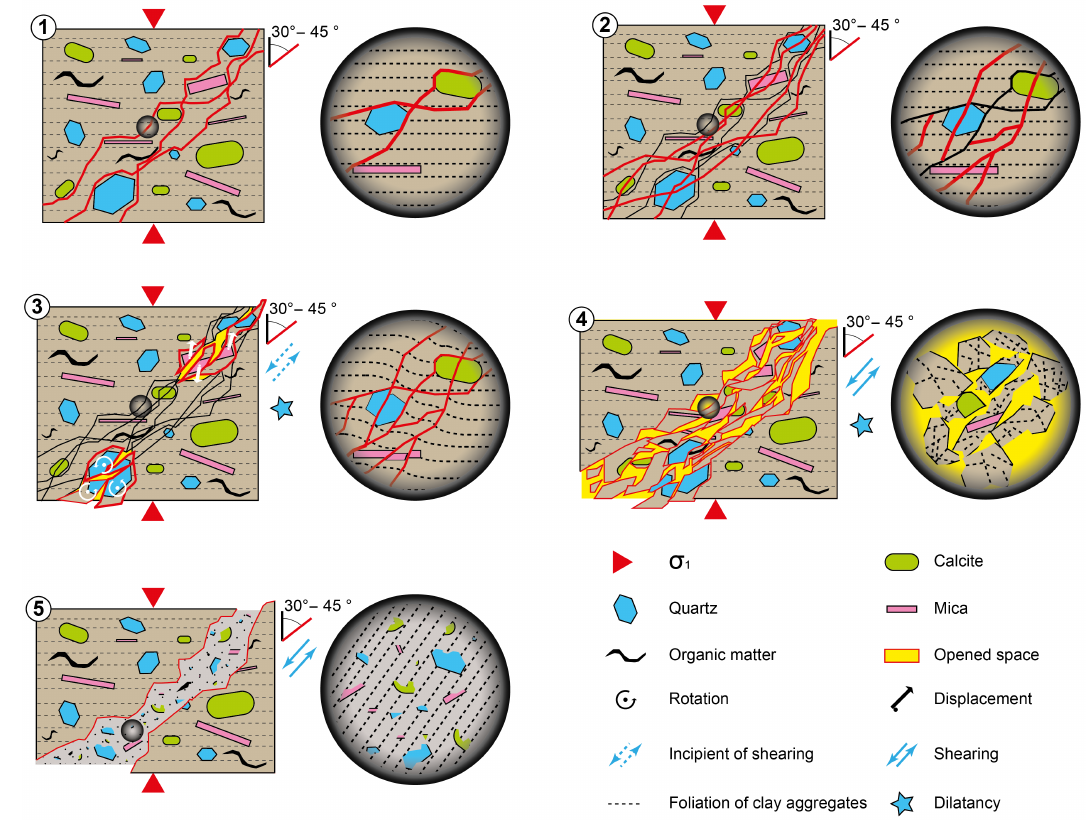
Figure 12. Conceptual model of microstructure development in triaxially deformed COX. (1) and (2) show microfracturing. In (1) intergran- ular microcracking initiating at non-clay minerals and clay minerals (NCM–CM) interfaces and propagating within CM. In (2) fragmentation of original fabric by transgranular and intragranular microfracturing of NCM. (3, 4) Cataclastic shearing with plasticity of phyllosilicates, macroscopic failure. In (3) incipient of shearing enhanced by plasticity of phyllosilicates at microfracture boundaries initiates cataclastic flow of original fabric’s fragments. In (4) ongoing shearing drives cataclastic flow, and reworking of CM in original fabric’s fragments. (5) Resealing of the damage zone by shear and pore collapse, evolution of clay gouge. See text for details. CM: clay matrix; NCM: non-clay